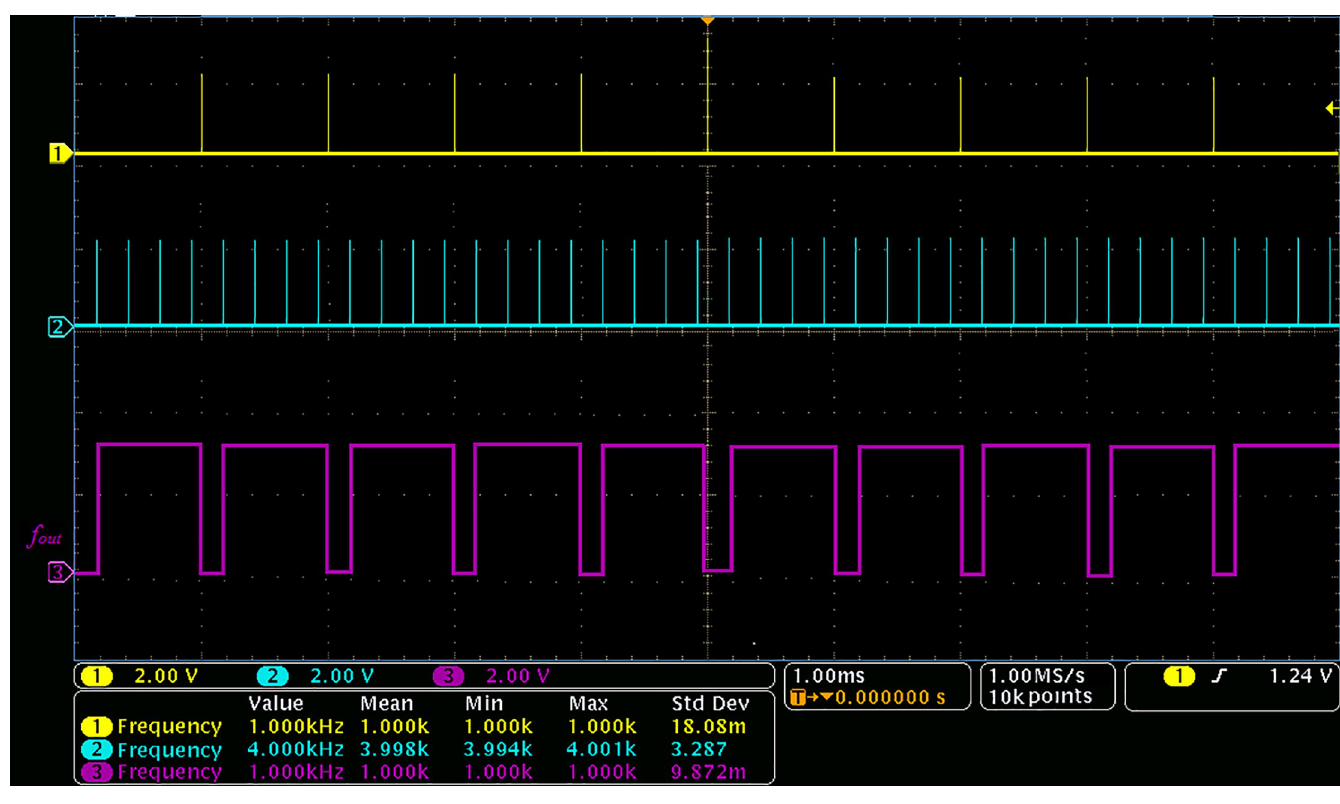
Fig 6. Direct phase comparison test